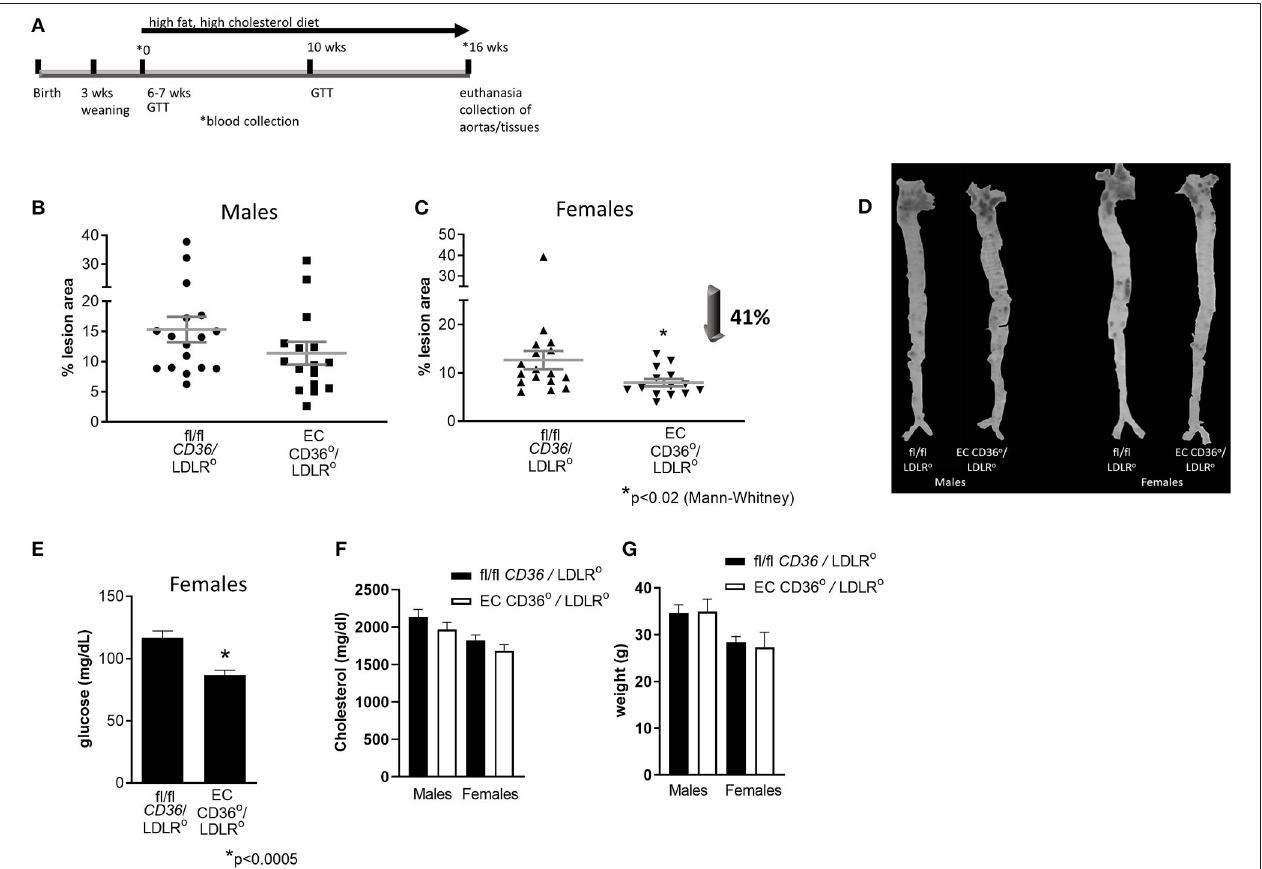
FIGURE 6 | Atherosclerosis lesion analysis. En face oil red O aortic lesions were quantified using Adobe Photoshop software after 16 weeks high-fat high-cholesterol diet feeding. (A) Timeline of atherosclerosis study. This was a longitudinal study. Mice were weaned at 3 weeks of age, and the high-fat, high-cholesterol diet was begun when the mice were 6–7 weeks of age. Just prior to the diet start (0), glucose tolerance testing (GTT) was performed and blood was collected; this and other blood collection timepoints are indicated by *. GTT was also performed after 10 weeks of diet feeding. Mice were euthanized and aortas, blood, and tissues were collected after 16 weeks of diet feeding. (B) Male mice showed no difference in percent atherosclerosis lesion (fl/fl CD36 /LDLR ◦ : 15.31 ± 2.096% vs. EC CD36 ◦ /LDLR ◦ : 11.37 ± 1.884%) (fl/fl CD36 /LDLR ◦ , n = 17; EC CD36 ◦ /LDLR ◦ , n = 16). (C) Female EC CD36 ◦ /LDLR ◦ mice showed a significant 40% decrease in percent atherosclerosis lesion compared with controls (fl/fl CD36 /LDLR ◦ : 12.65 ± 1.896% vs. EC CD36 ◦ /LDLR ◦ : 7.447 ± 0.897%, p < 0.02, Mann–Whitney) (fl/fl CD36 /LDLR ◦ , n = 17; EC CD36 ◦ /LDLR ◦ , n = 14). (D) Representative aortas stained with oil red O. (E) Female EC CD36 ◦ /LDLR ◦ mice had significantly lower fasting glucose compared with controls. (F) Total cholesterol showed no differences in males (fl/fl CD36 /LDLR ◦ : 2,132 ± 103.4 mg/dL vs. EC CD36 ◦ /LDLR ◦ : 1,967 ± 96.42 mg/dL) or females (fl/fl CD36 /LDLR ◦ : 1,824 ± 68.94 mg/dL vs. EC CD36 ◦ /LDLR ◦ : 1,680 ± 84.2 mg/dL) at endpoint. (G) Weights were not different at endpoint in males (fl/fl CD36 /LDLR ◦ : 35.51 ± 1.34g vs. EC CD36 ◦ /LDLR ◦ : 34.88 ± 0.673g) or females (fl/fl CD36 /LDLR ◦ : 28.6 ± 0.78g vs. EC CD36 ◦ /LDLR ◦ : 27.27 ±